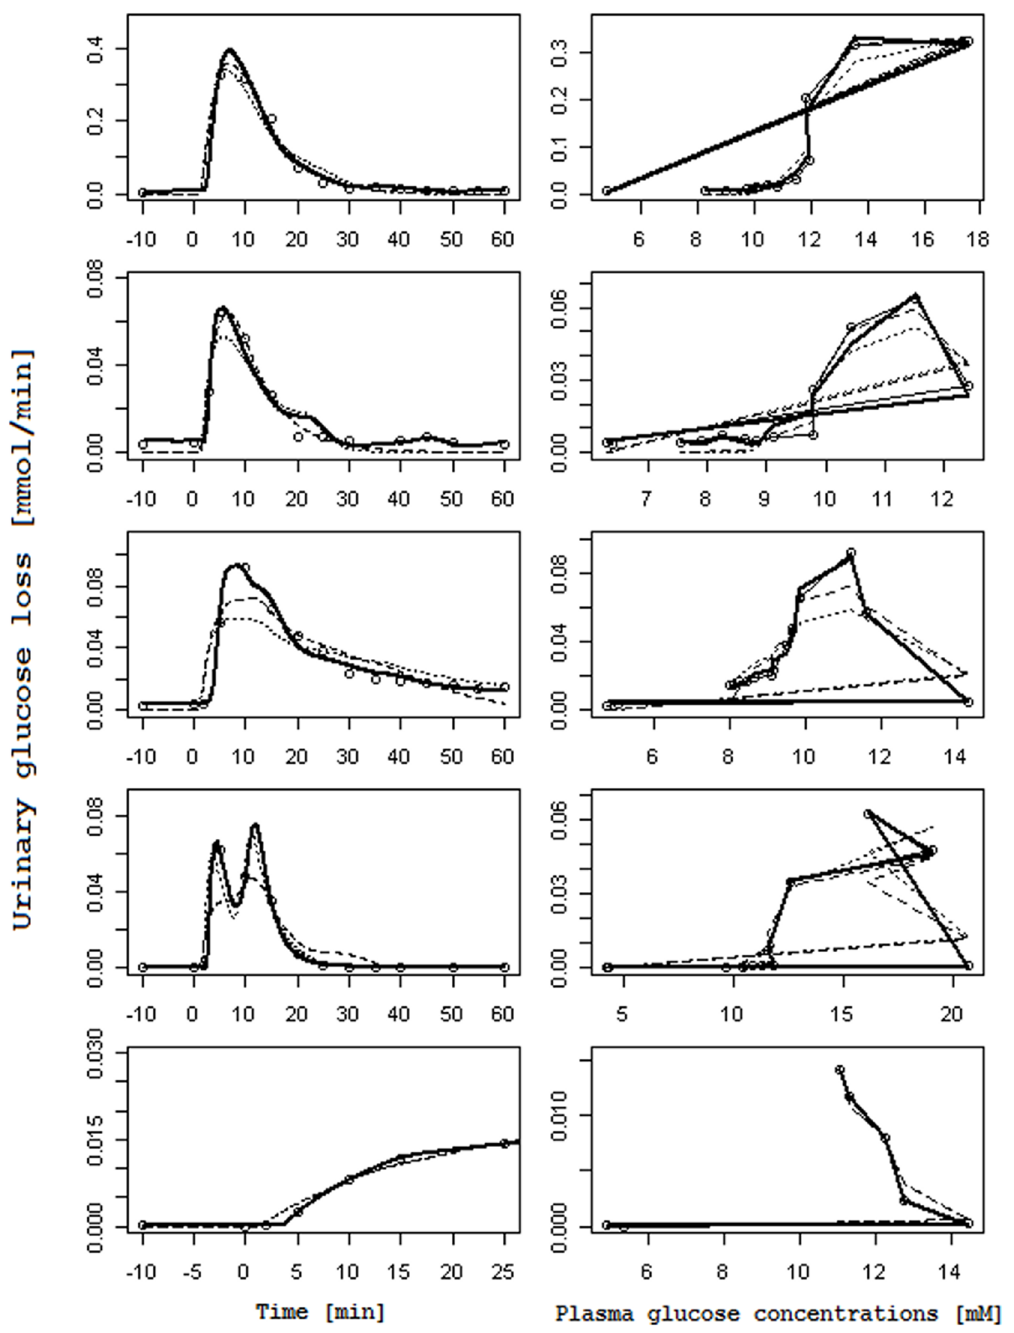
Figure 3. Observed and predicted urinary glucose loss when plasma glucose concentrations are interpolated. Columns on the left report the observed Urinary glucose loss [mmol/min] (circles) over Time [min] along with their prediction obtained with the RTH model letting the Slope vary (dashed line), with the RTH model fixing the Slope at 1 (dotted line) and with the PTR model (thick continuous line). Columns on the right report the same observed Urinary glucose loss (circles), linked with a thin continuous line, in correspondence of the interpolated observed Plasma glucose concentrations [mM], along with urinary glucose loss predictions obtained with the RTH model letting the Slope vary (dashed lines), with the RTH model fixing the Slope at 1 (dotted line) and with the PTR Model (thick continuous